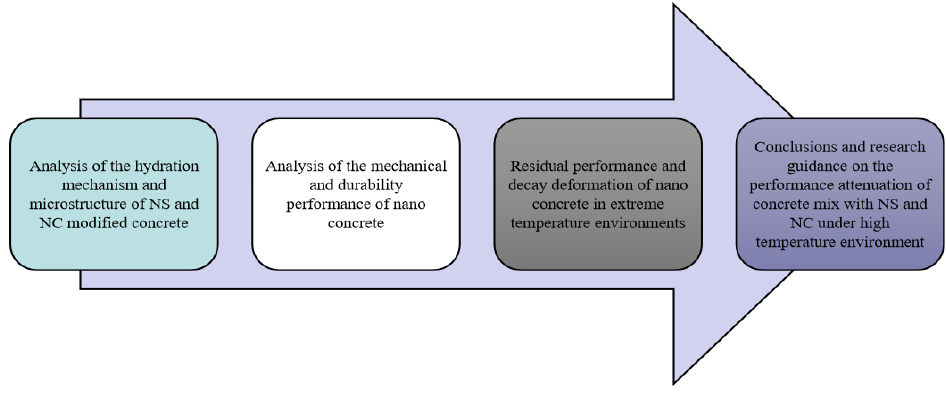
Figure 2. Flow chart of research methodology.